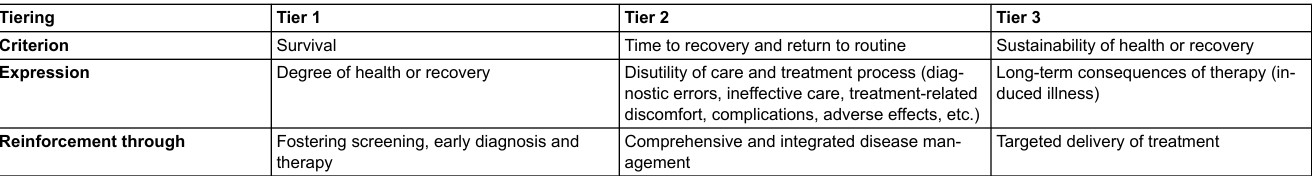
Table 2: Application of the outcome measures hierarchical tier system described by Porter to reinforcement interventions proposed as solutions to the shifting the burden arche- type in the in-vitro diagnostics arena [52]. Tiering